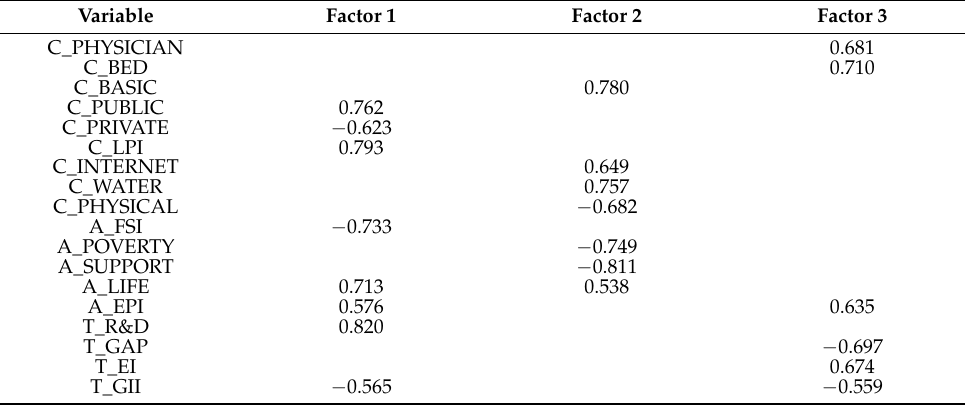
Table 3. The results of common factor